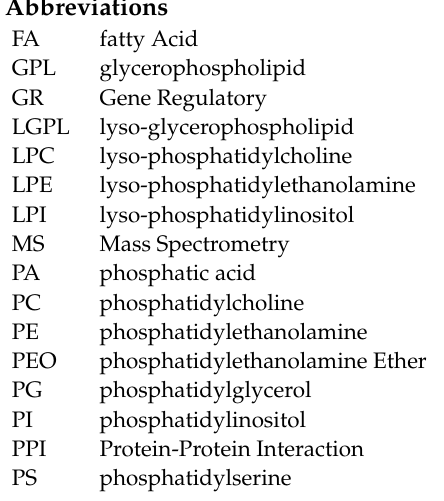
Figure 2, Supplementary Data 2: Interactive HTML of the network shown in Figure 3, Supplementary Data 3: Interactive HTML of the network shown in Figure 4, Supplementary Data 4: Lipid Class Color Scheme.